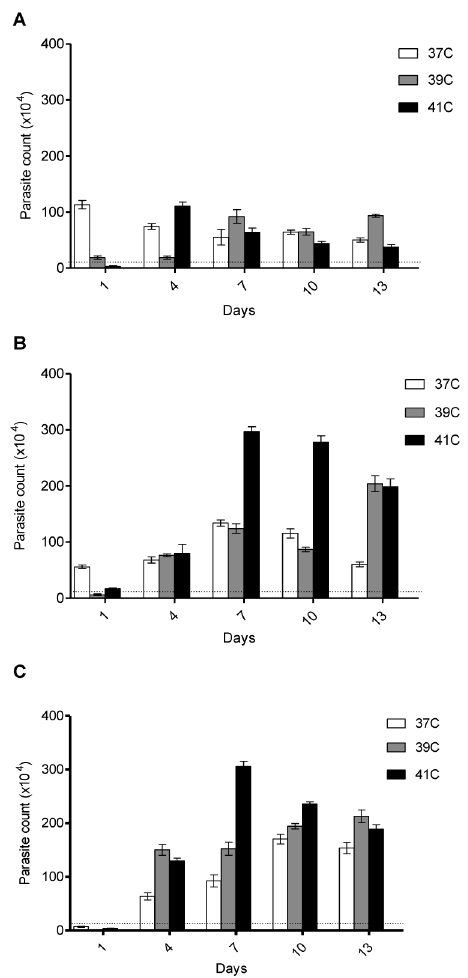
Figure 1. Growth of Blastocystis sp. Controlled temperature (37 u C) and thermal stress temperatures (39 u C and 41 u C) were used. (A) Subtype 1 did not show significant growth difference between control and thermal stressed isolates. (B) Subtype 3 and (C) Subtype 5 which thermal stressed at 41 u C showed significantly higher growth compared to isolate at 37 u